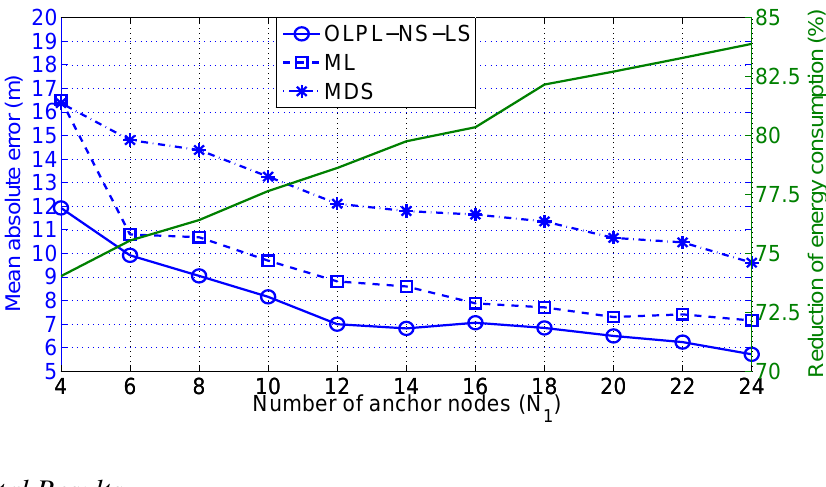
Figure 9. Mean absolute error versus number of anchor nodes ( N 1 ) ( solid line: On-Line Path Loss and Node Selection Least Squares, dashed line: Maximum Likelihood, dash-dotted line: MultiDimensional Scaling ).